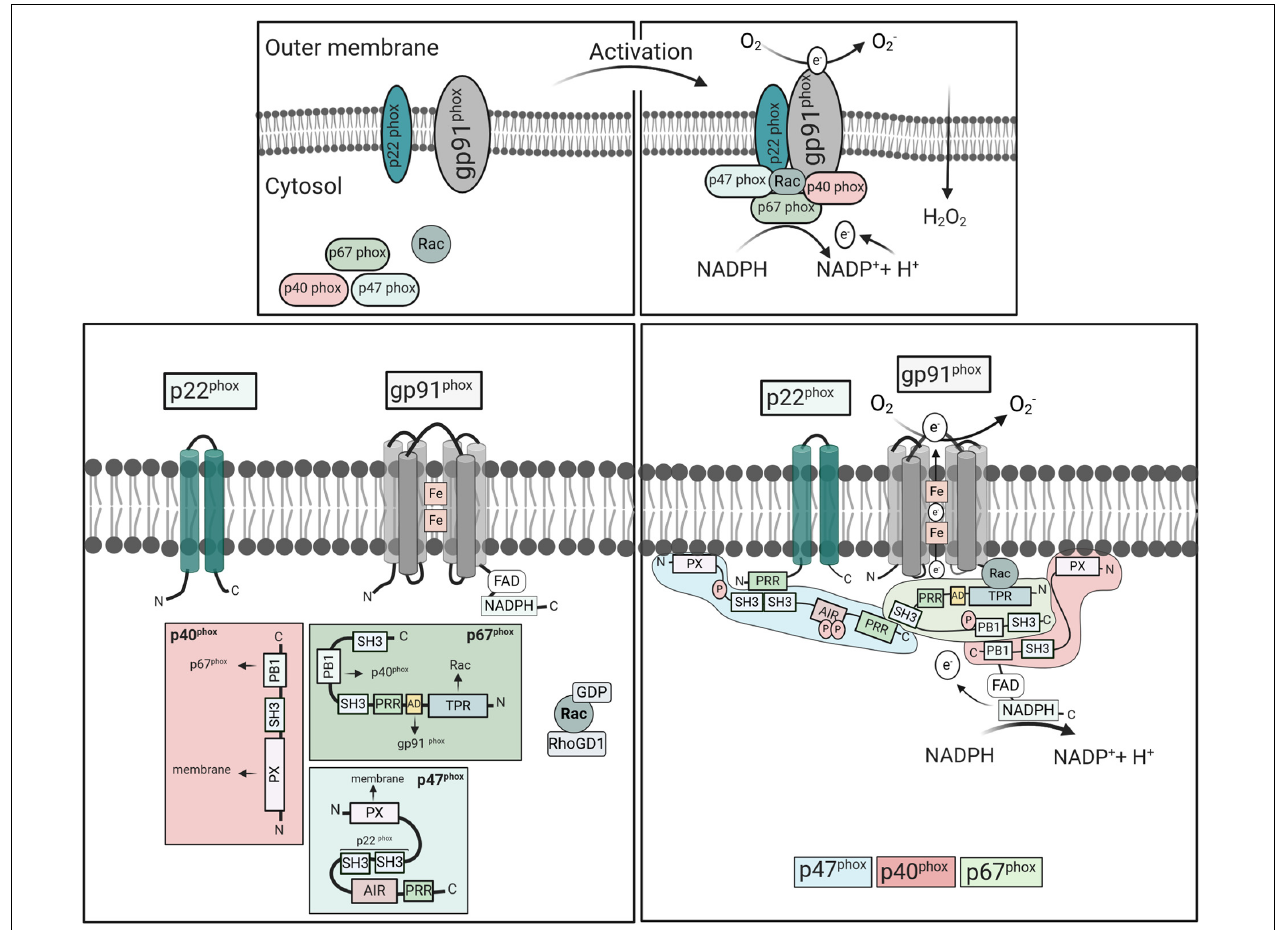
FIGURE 2 | Activation and assembly of mammalian NOX2. NOX2 consists of the cytosolic components p67 phox , p47 phox , p40 phox , Rac2, and the integral membrane subunits gp91 phox and p22 phox . Upon cell stimulation, the cytosolic subunits translocate to the membranes to form an active complex with gp91 phox and p22 phox . Meanwhile, Rac exchanges GDP to GTP, and dissociates from Rho-GDI. In the resting state, the p47 phox -SH3 tandem domain interacts with AIR keeping p47 phox in an inactive conformation (Belambri et al., 2018). Cell stimulation induces phosphorylation of AIR, releasing the interactive domains, i.e., SH3, PX, and PRR, which mediate oxidase assembly. The PRR of p47 phox binds to the SH3 region of p67 phox , while p67 phox links with p40 phox through their PB1 domains. The p47 phox -SH3 regions then bind to the p22 phox -PRR domains promoting p67 phox interaction with gp91 phox and moving p40 phox -PX domains in close proximity to the membrane. Activated NOX2 uses cytosolic NADPH to induce oxygen reduction and superoxide anion (O 2 · -) generation. Abbreviations: SH3, Src homology 3 (SH3),; PX, phox homology (PX),; AIR, auto-inhibitory region (AIR),; PRR, proline-rich region (PRR),; TPR, tetratricopeptide-rich regions; PB1, phox and Bem1 domain; and AD, activation